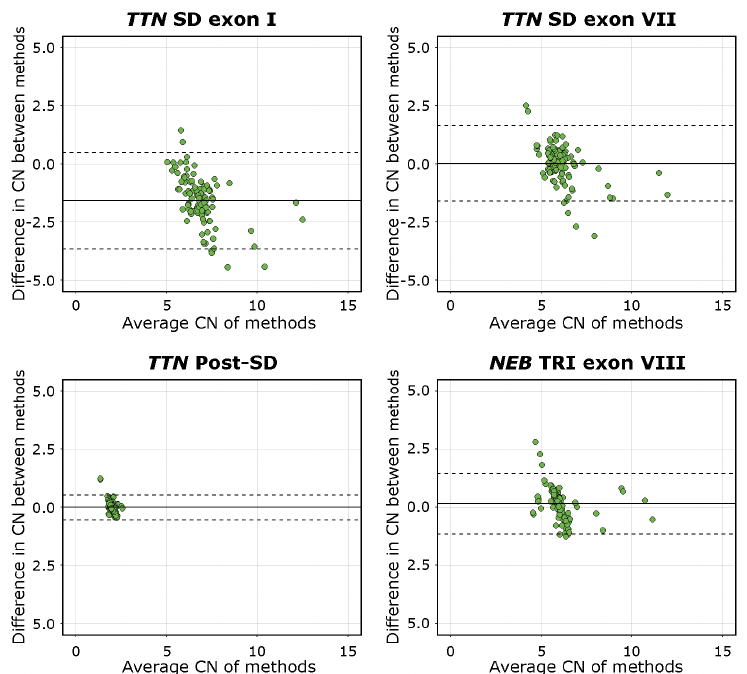
Figure 4. Bland-Altman plots of all assays. The solid line represents the mean difference, and the dashed lines represents the upper and lower limits of the 95% C.I. Mean values approaching 0 indicate a higher level of agreement between the compared methods, as seen for the TTN SD exon VII, TTN Post-SD, and NEB TRI exon VIII assays. The mean of differences of the TTN SD exon I assay deviates from 0 and approaches an absolute value of 2.0, which is the expected difference in CN estimates derived using the different methods.